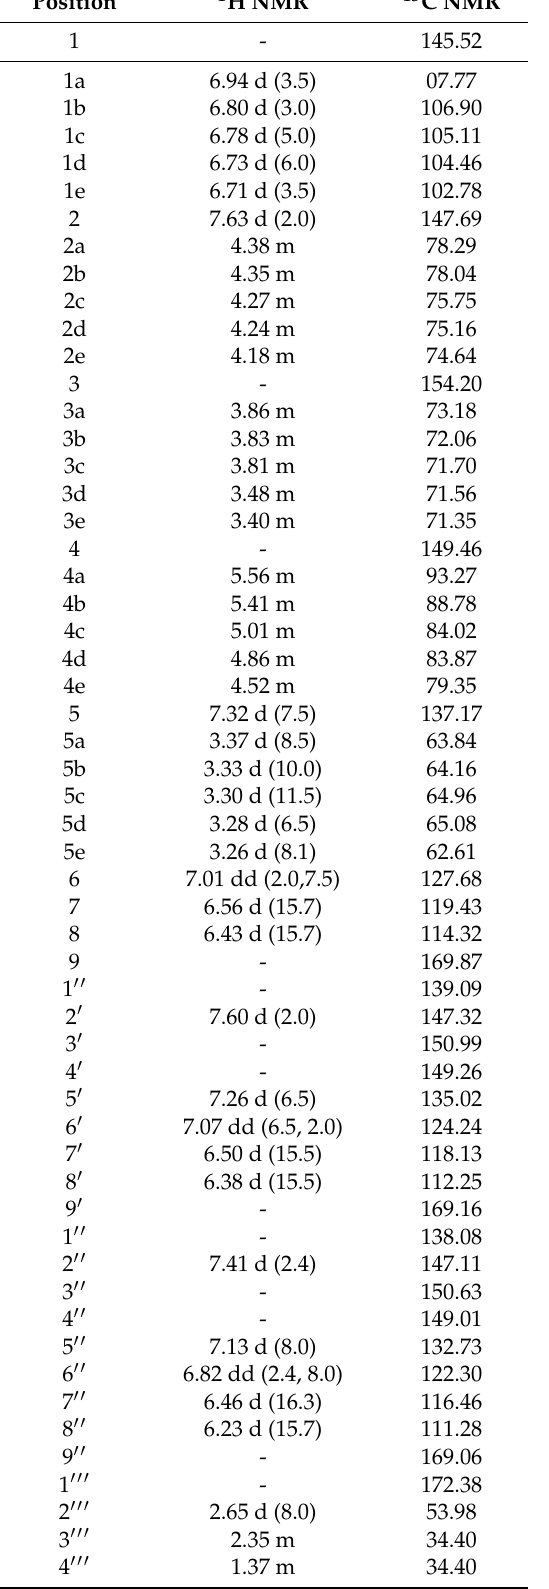
Table 4. 1 H NMR and 13 C NMR Spectroscopic data of compound 4